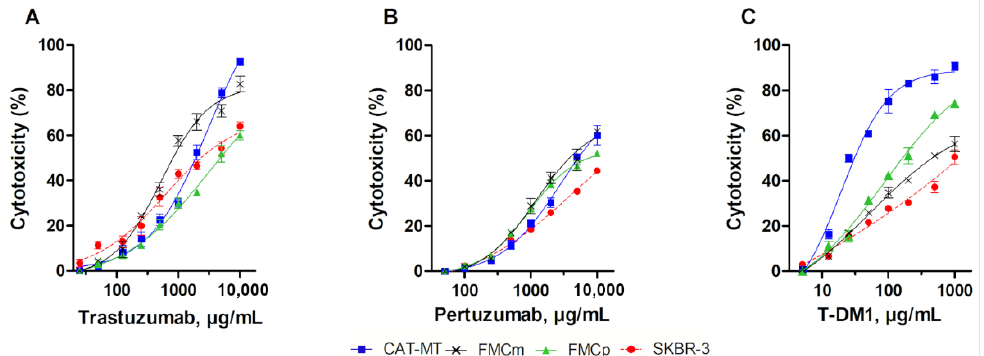
Figure 1. Trastuzumab, pertuzumab and T-DM1 presented strong antiproliferative effects on feline mammary carcinoma cell lines. ( A ) CAT-MT cells exposure to trastuzumab allowed to obtain a maximum of 92.6% of cytotoxicity. ( B ) Cell lines exposure to pertuzumab presented a lower antiproliferative effect, with a maximum of 61.8% of cytotoxicity in the FMCm cells. ( C ) T-DM1 had the highest antiproliferative effect in the CAT-MT cells, with 94.0% of cytotoxicity. The experiments were performed in triplicates, in three independent assays.